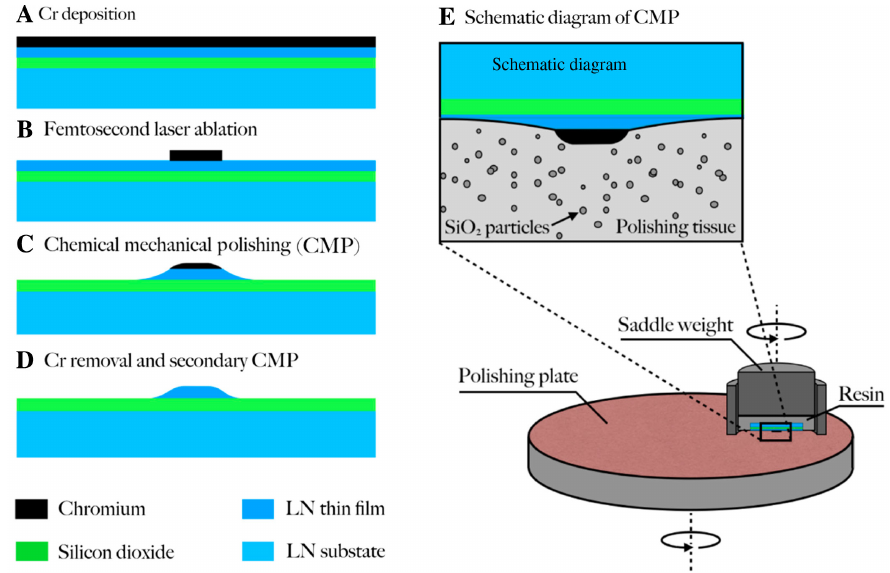
Figure 4: A standard fabrication process of chemical mechanical polishing (CMP). (A) Cr thin film is first deposited on a LNOI wafer and is ablated by femtosecond laser (B) to define the pattern. Then, CMP is implemented (C) to polish lithium niobate thin film. Finally, Cr mask is removed by wet etching and secondary CMP is implemented for a smoother surface (D). (E) shows a schematic diagram for the CMP process. Reprinted with permission from Wu et al. [57].